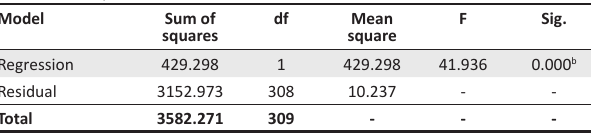
FIGURE 3: Linear regression model on employees’ aptitudes and trepidations and actual adoption of enterprise application architecture slope (+0.19) of good results. Given the average change in the y-variable (in this case: Actual adoption of enterprise application architecture) for a change in the x-variable (employees’ aptitudes and trepidations) on one unit.